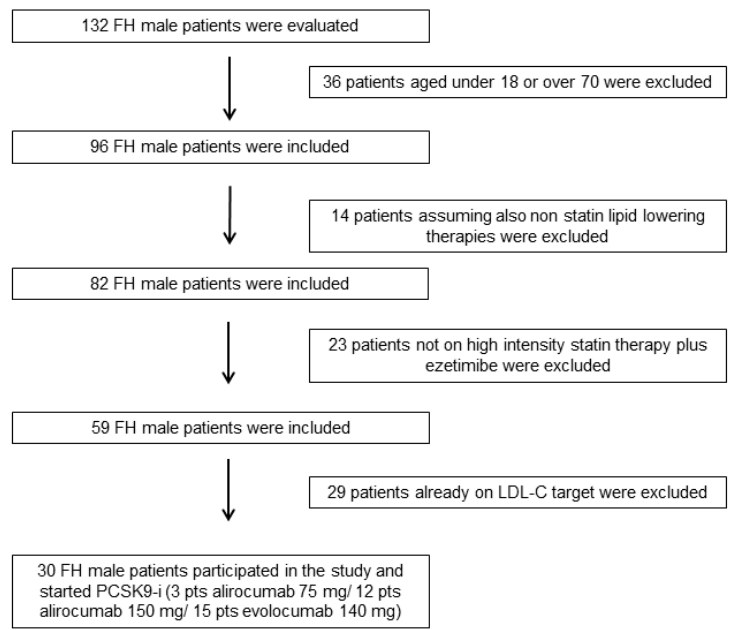
Figure 1. Enrollment flowchart of the study population. FH = familial hypercholesterolemia, PCSK9-i = proprotein convertase subtilisin/kexin type 9 inhibitors.